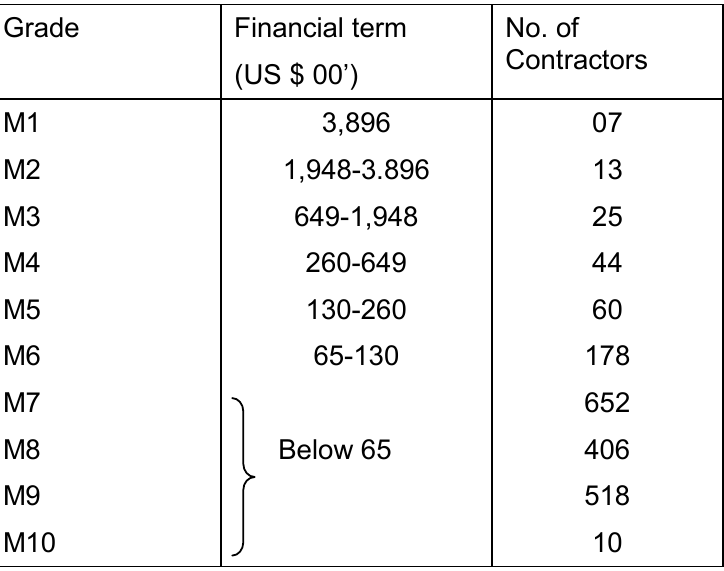
Table 6. Grading of Sri-Lankan Contractors by